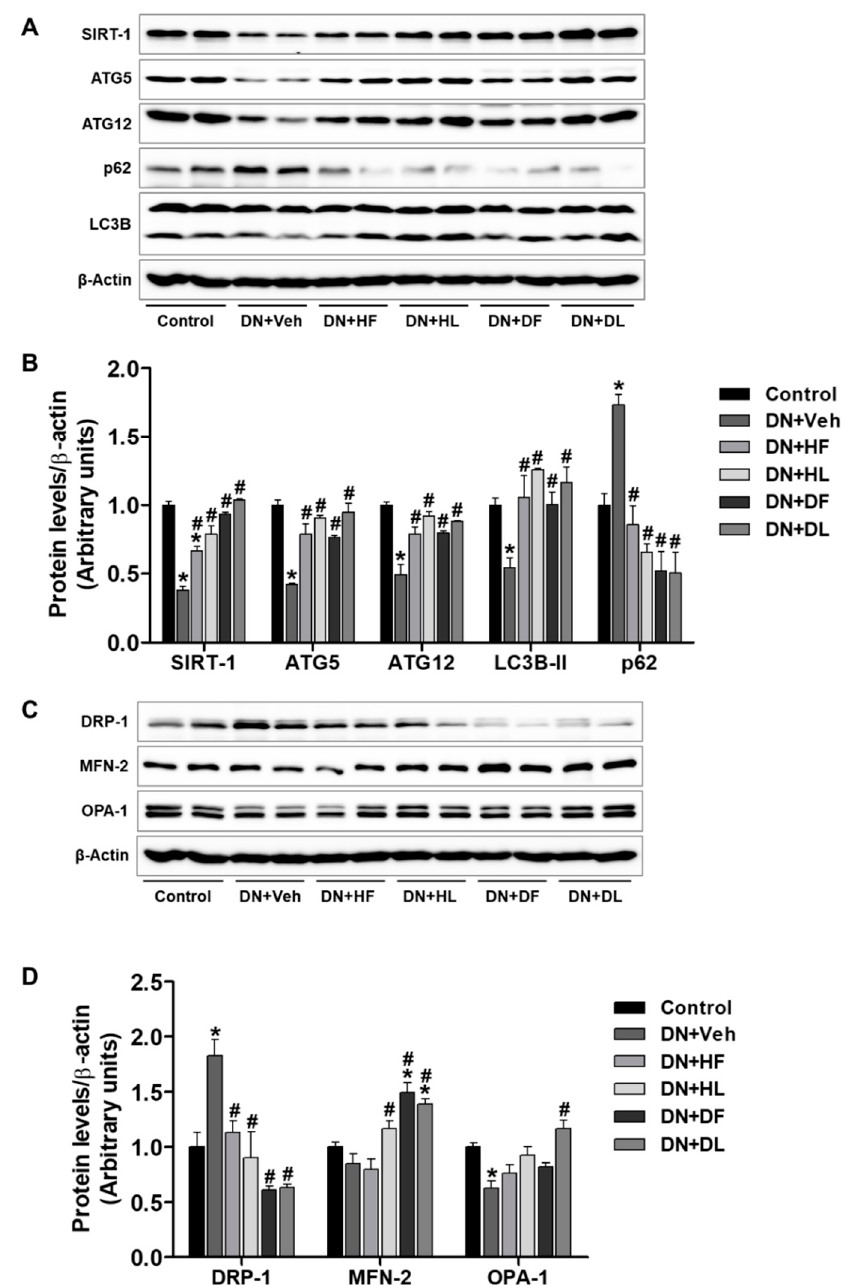
Figure 4. AM extract treatment changed renal expression of autophagy and mitochondrial regulatory proteins in DN mice. Kidney tissues were lysed for Western blot analysis and protein expression levels of autophagy proteins (SIRT-1, ATG5, ATG12, p62, and LC3B). Mitochondrial regulatory proteins (DRP-1, MFN-2, and OPA-1) are shown. The quantitative analysis is included. Western analyses on autophagy ( A , B ) and mitochondrial regulatory proteins ( C , D ) are shown. The data are presented as the mean ± SEM. * p < 0.05 versus the control, # p < 0.05 versus DN mice.